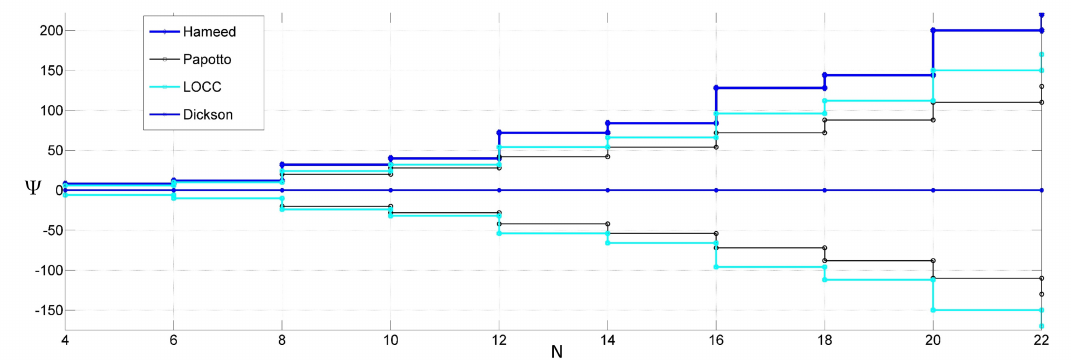
Figure 13. Rectifier class versus the number of stages for different threshold-compensation